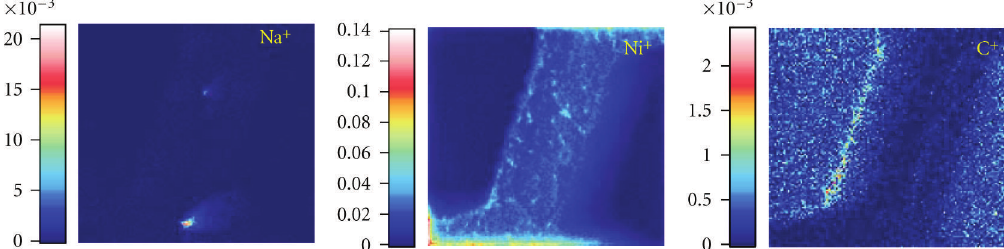
Figure 4: Secondary ion images for sodium, nickel, and carbon from part of a nickel finder grid on an adhesive carbon patch. Field of view is 20 × 20 microns. Oxygen flooding was used to enhance the nickel signal. Because the full dataset is three dimensional, it could be shown that the sodium signal was only present at the surface of the sample. The colour scale intensity units are ions per raw voxel (1024 × 1024 × 178); for display purpose the data has been binned to 128 × 128 ×